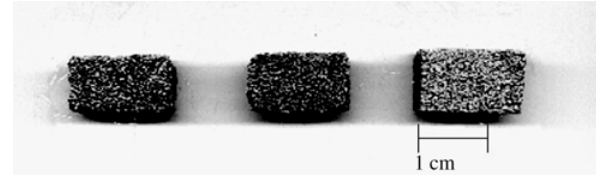
Figure 4. CT image of 75 ppi ceramic sample (9 × 11mm 2 ) meas- ured at 28.3 keV.